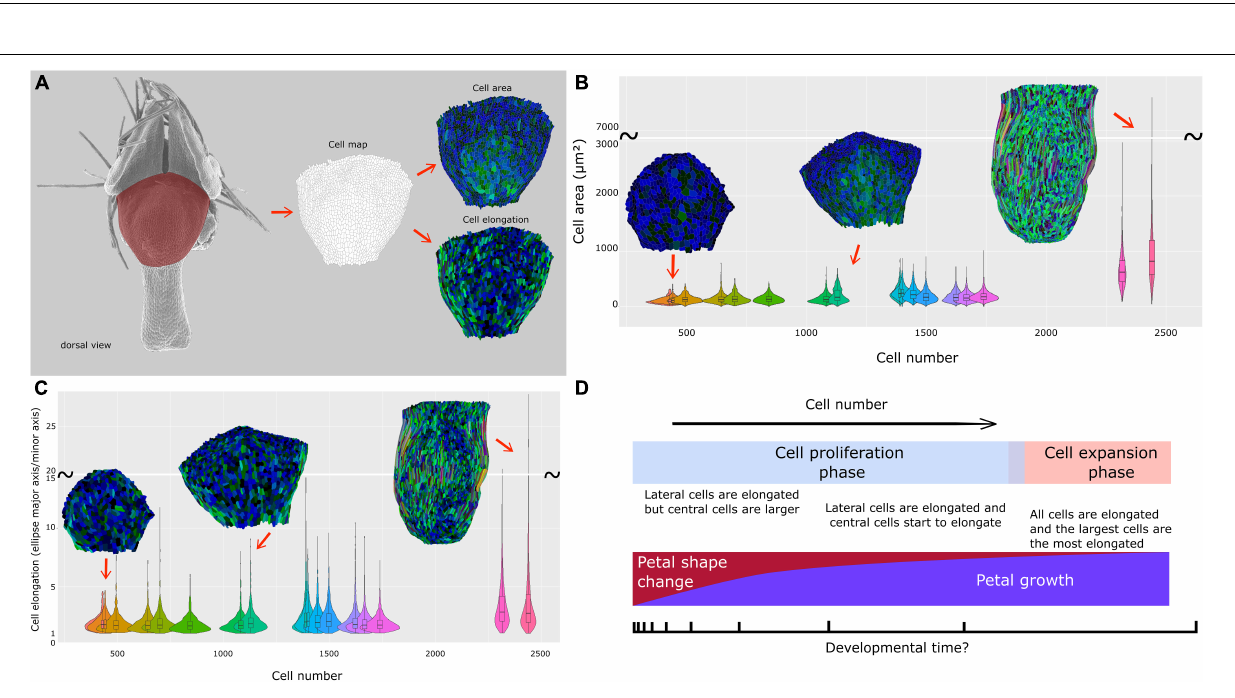
Frontiers in Plant Science |